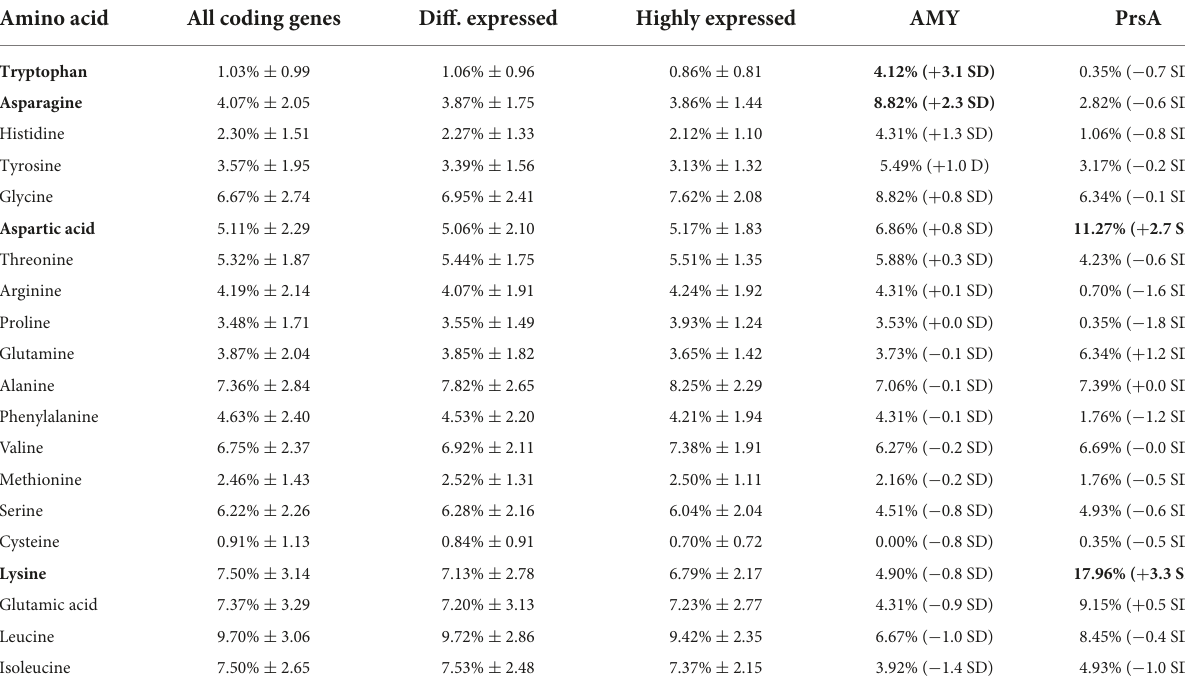
TABLE 2 Amino acid